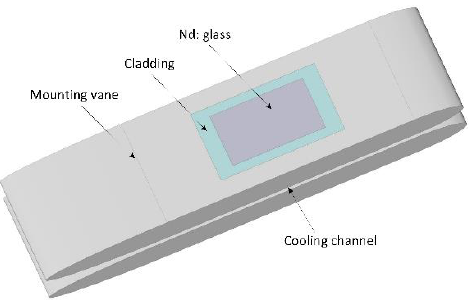
Figure 1. Three-dimensional (3D) structure diagram of the two gain slabs with mounting vanes and a cooling